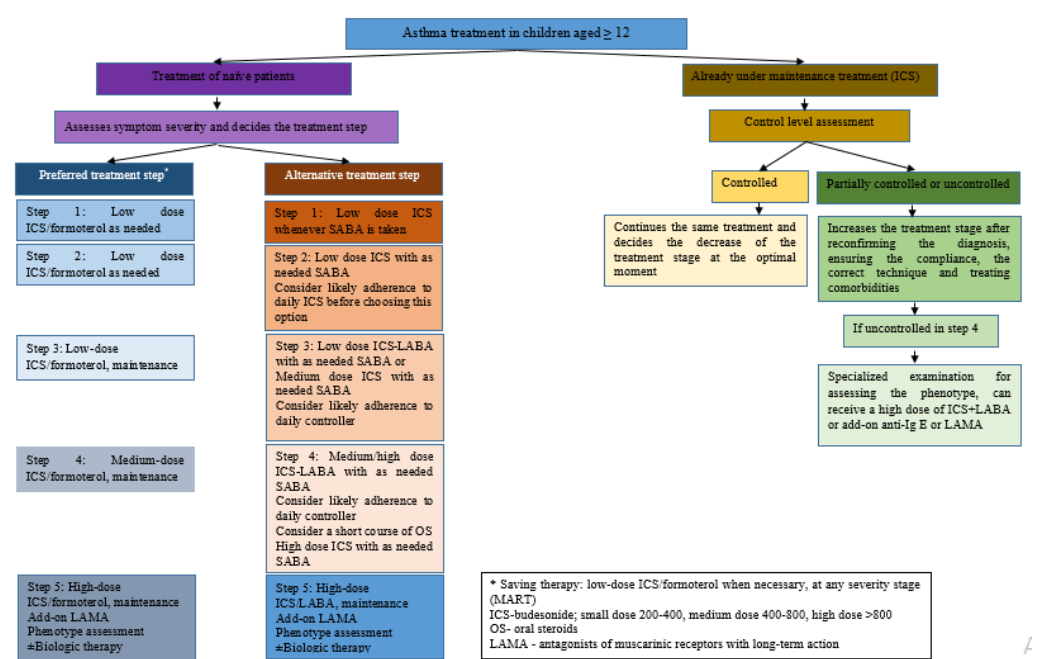
Figure 2. Asthma treatment based on GINA 2022 recommendations for children aged ≥ 12 and adapted from Recent Advances in Long-Term Management of Asthma (published online ahead of print, 20 January 2022). Indian J Pediatr. 2022 [42].